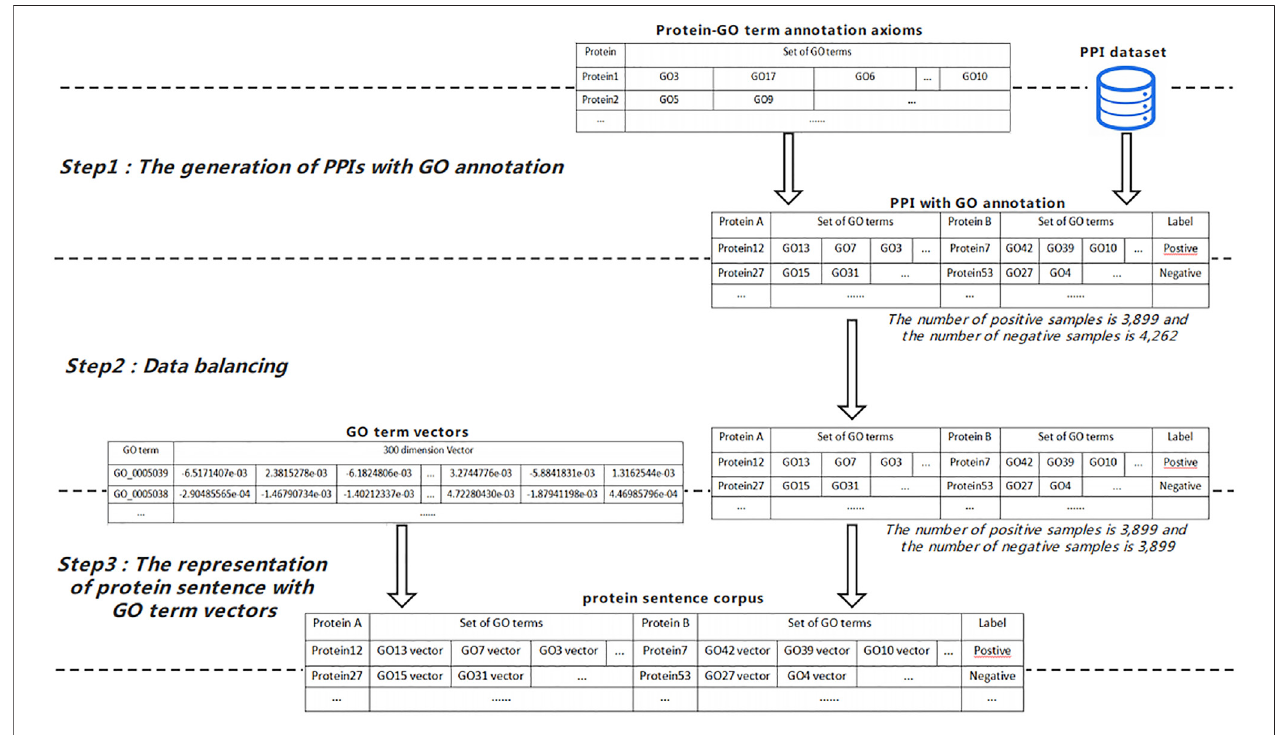
FIGURE 3 | The work fl ow of the protein sentence representation.